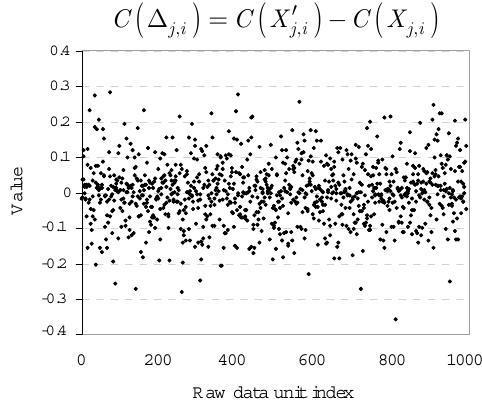
(cid:16) (cid:17) (cid:16) (cid:17) (cid:16) (cid:17) ∆ = C − C X (cid:48) j , i X j , i on the CDF-transformed raw j , i